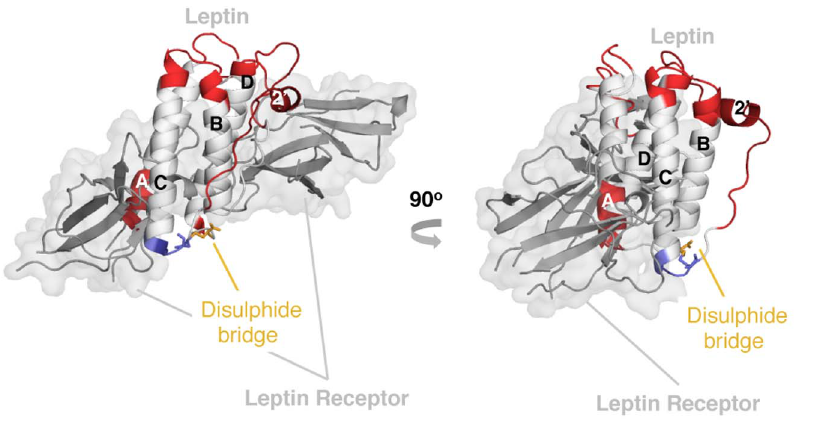
Figure 6. Crystal structure of the leptin receptor complex. The figure shows the leptin receptor complex (PDB code 1AX8 and 3V6O, [40]). The structure of leptin is color-coded according to changes in NSDs, where increased dynamics in the oxidized state is shown in red and increased dynamics in the reduced state is shown in blue. It is clear that there are more dynamics in the oxidized state versus the reduced state. Interestingly, the largest changes in the oxidized state occur at the receptor interface. Previously published results from in vitro activity assays in human cell lines showed that oxidized leptin is more active than reduced leptin [12]. This suggests that leptin benefits from being malleable for receptor interaction.